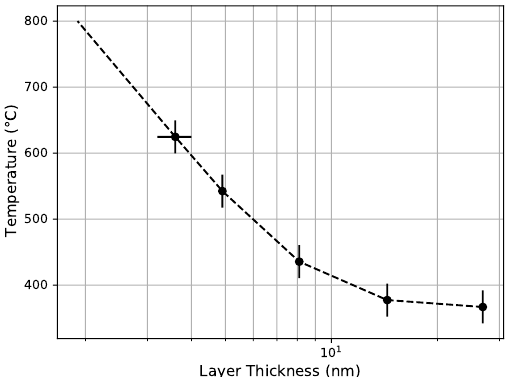
Figure 5. The crystallization temperature is shown as a function of the zirconia nano-layer thickness. Signs of crystallization appear at 800 ◦ C for the thinnest layers (1.9 nm, 1.5 nm, and 1.3 nm). However, they do not fully crystallize as we explained in this paper. Because of this, they are omitted from this